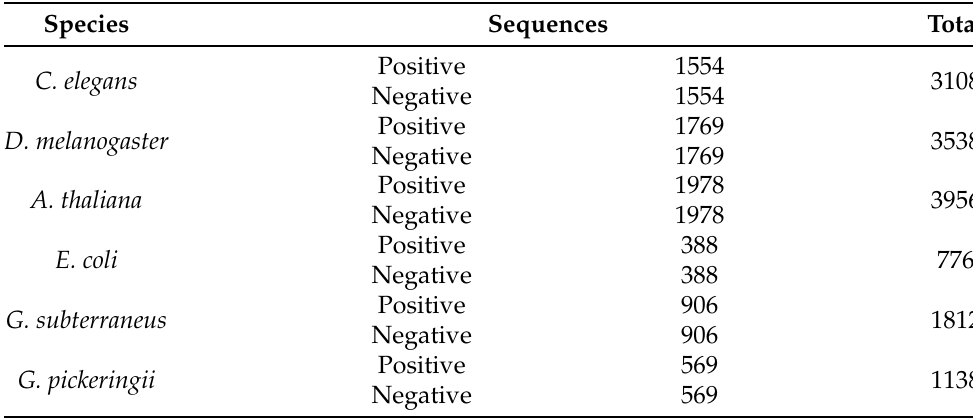
Table 1. The summary of six species benchmark